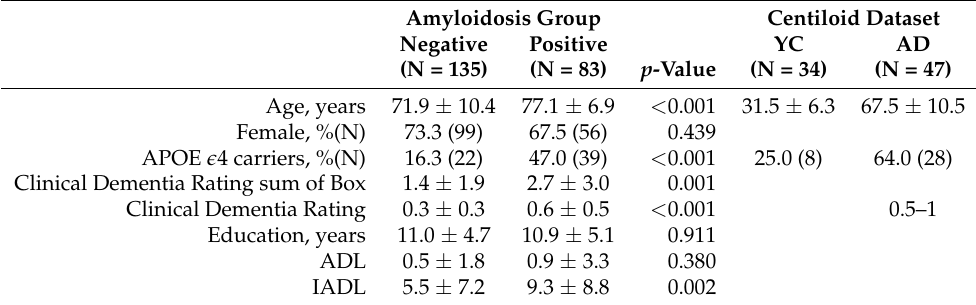
Table 1. The demographics of the amyloidosis-positive and negative groups. Mean (standard deviation) or percentage with the number of the subject N are reported. p -value was calculated from the t -test between two groups of in-house dataset. Note that the two subjects of YC and one subjects of AD in Centoloid dataset refused the APOE gene test. In the clinical dementia rating score of Centoloid dataset, the AD subject was in range of